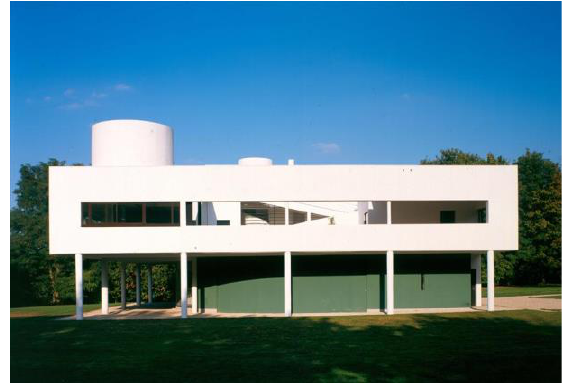
Figure 4. Villa savoye